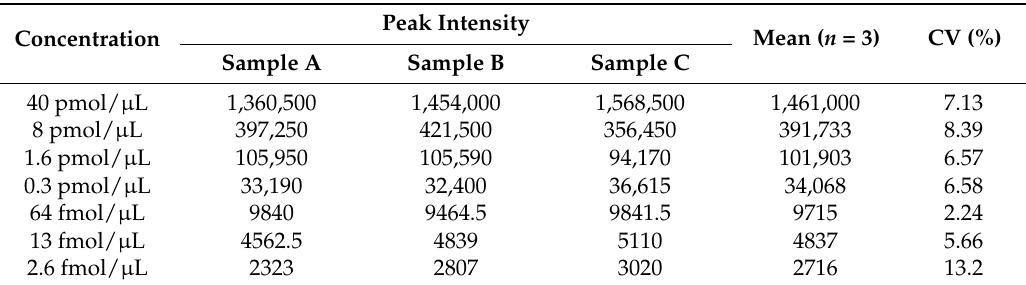
Figure 9. ( A ) Neutral loss ( m / z 92.0473) tandem mass spectra of an equimolar mixture (10 fmol/ µ L); ( B ) The peak area ratio of individual MAG species to MAG 17:1 ( n = 3). The full high-resolution MS and MS/MS data were collected using the MS/MS ALL mode under the following conditions: GS1 = 10, GS2 = 10, CUR = 15, Temp = 300 ◦ C, DP = 100 V, CE = 15 ± 10 V. The neutral loss scan MS/MS spectra was generated from the collected data retrospectively. Table 1. Reproducibility of the MS/MS ALL technique for Table 2. MAG Species Database.